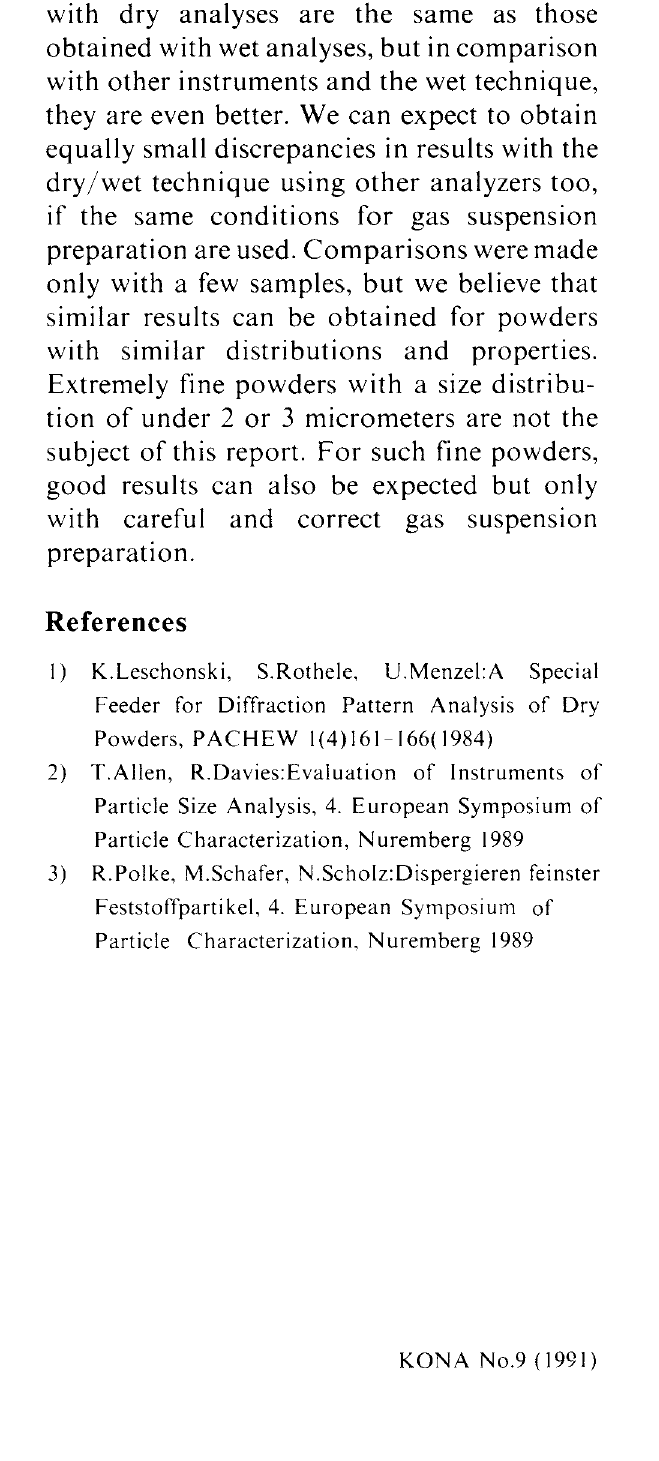
Fig. 9 Particle size analyses for the third example of classification